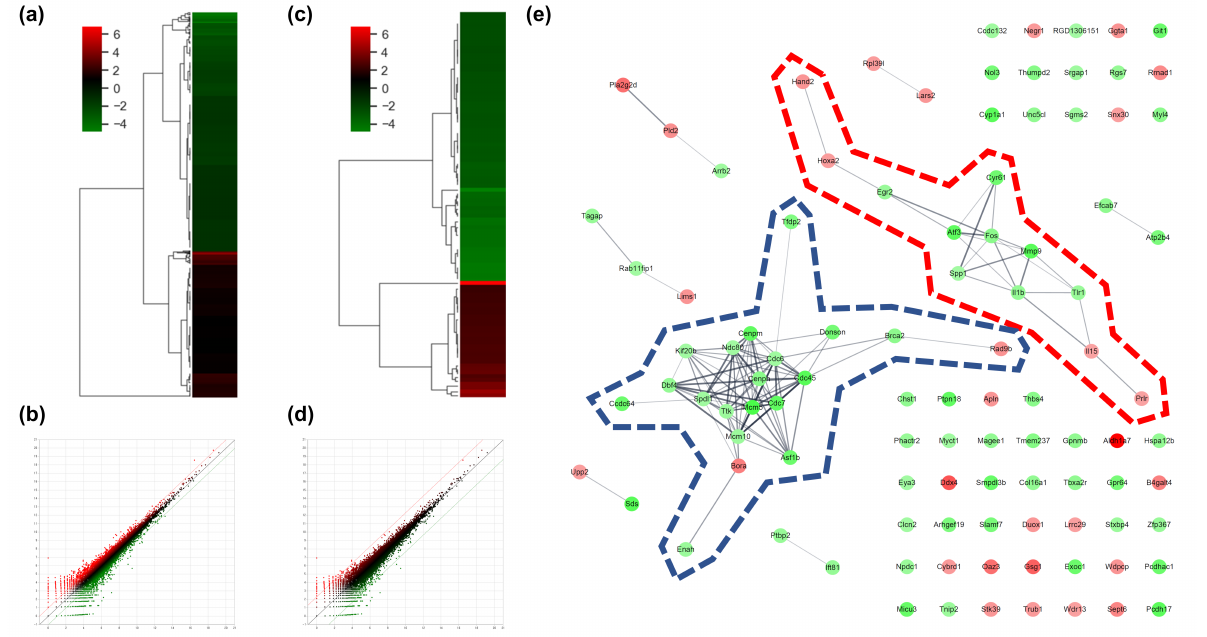
Figure 2. DEGs and gene network. ( a ) heatmap with hierarchical clustering of 2-fold changed DEGs, ( b ) expression pattern for 2-fold changed DEGs, ( c ) heatmap with hierarchical clustering of 5-fold changed DEGs, ( d ) expression pattern for 5-fold changed DEGs, ( e ) Gene network of 5-fold changed DEGs. 20 DEGs (in blue dotted line) and 12 DEGs (in red dotted line) were clustered. Markedly, DEGs within the blue dotted line showed strong relation. 14 other DEGs (not marked) were linked with only one or two genes. The green color in the figure indicates decreased expression; the red color in the figure indicates increased